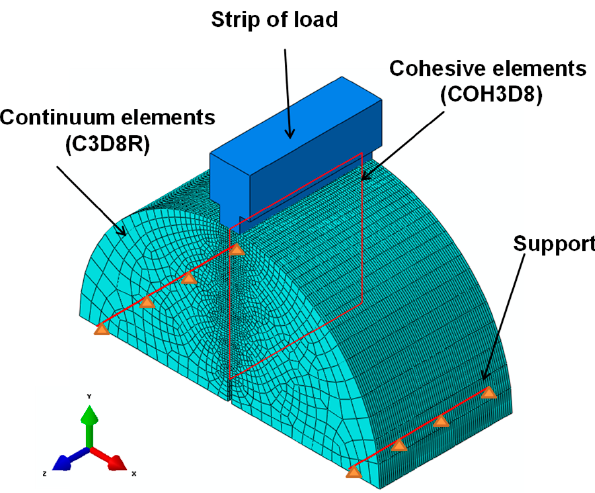
Figure 4. Model for the test specimen of the 3PSCBT.